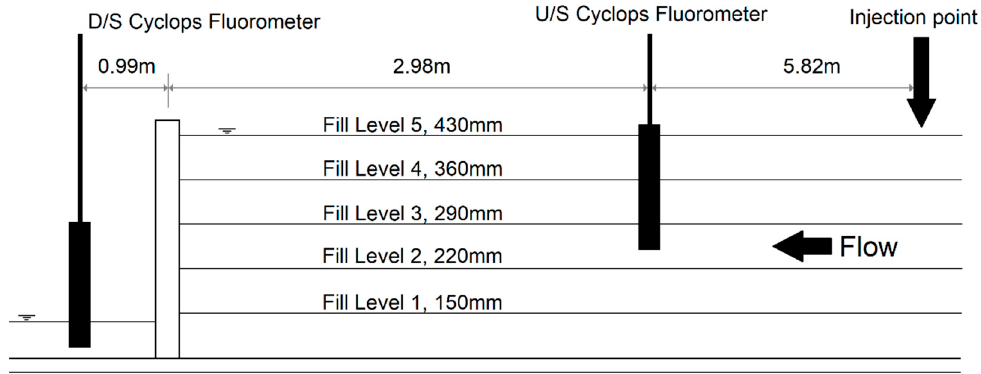
Figure 2. Layout of dam use in experiments. Holes are representative and are not to scale in size, distribution or number. Black areas represent the surface of the dam that is blocked, and thus impermeable.